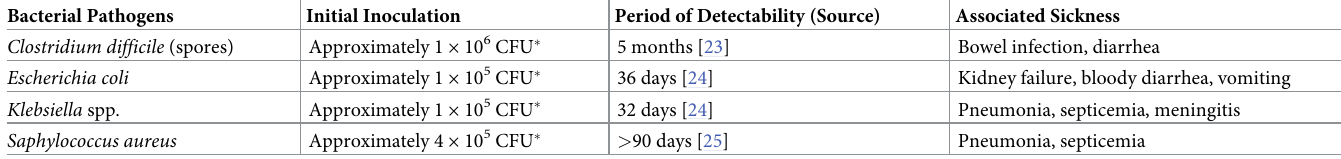
Table 1. Persistence of bacterial pathogens on dry common inanimate surfaces (e.g., plastics, stainless steel, or flooring). Bacterial Pathogens Initial